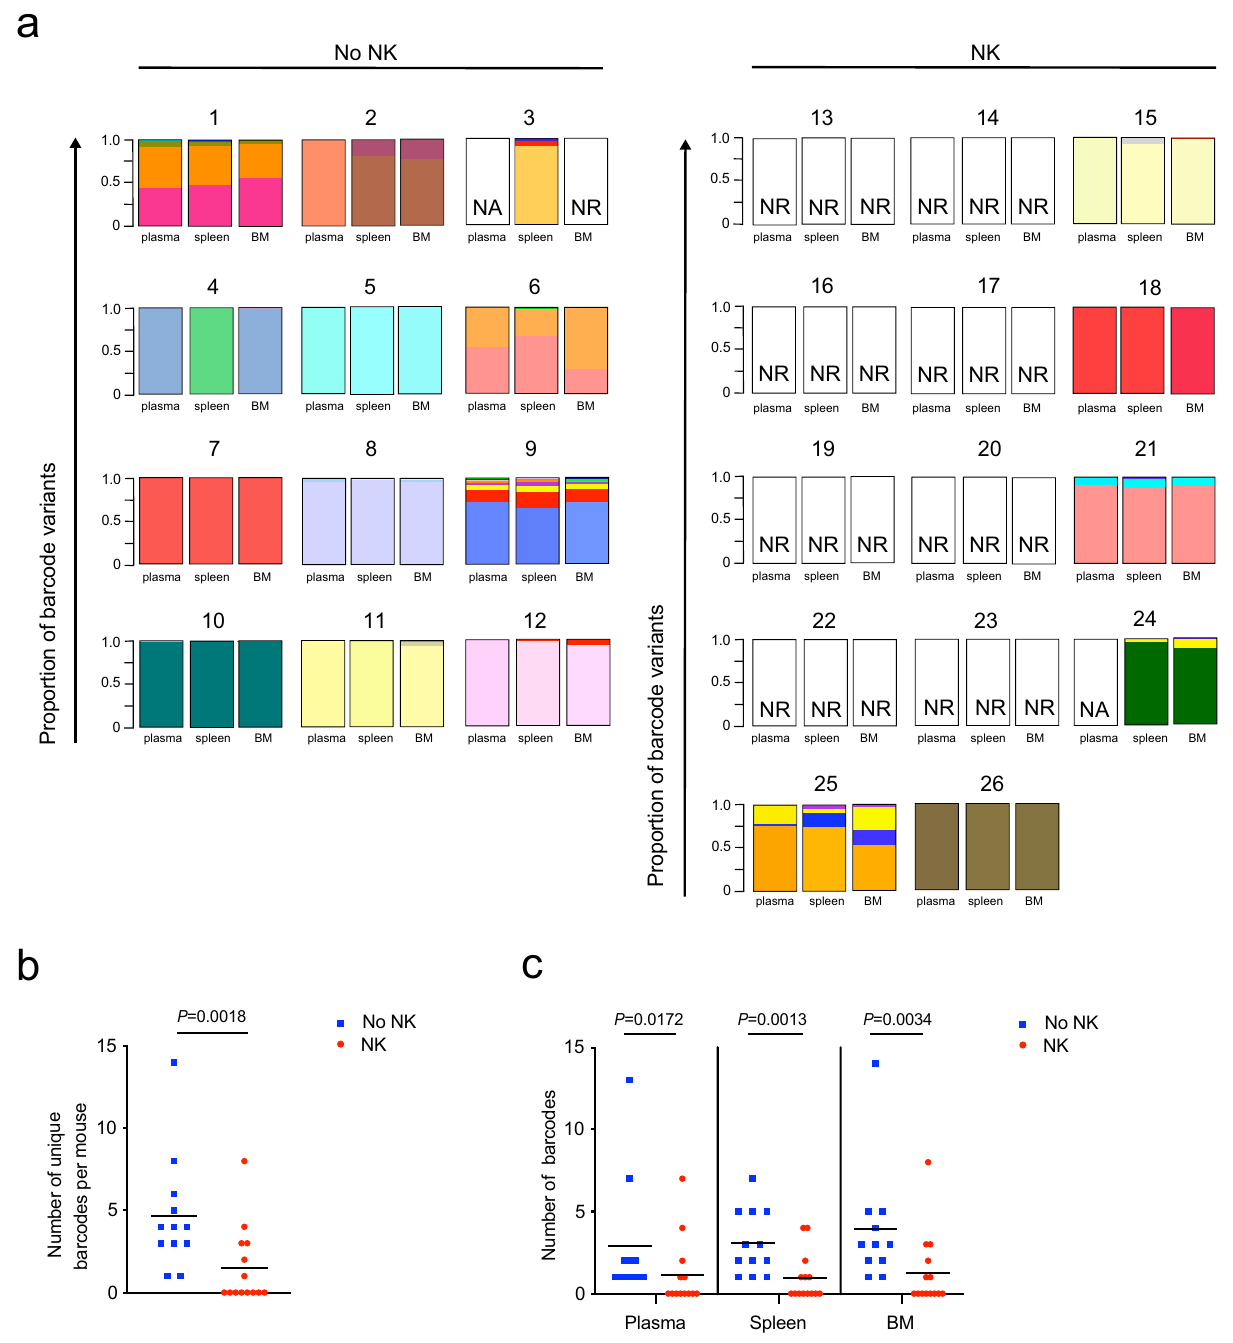
Fig. 4 NK cells decrease barcode diversity in NL-HABC infected mice. a Stacked bar plots display the relative frequencies and distribution of major barcode variants identi fi ed in the plasma, spleen, and bone marrow “ BM ” of mice treated with or without NK cells during ART interruption described in Fig. 2. Individual barcodes are represented by one color. “ NR “ is no rebound, undetectable HIV RNA copies measured by qRT-PCR. “ NA ” is no amplicon detected of the barcode region by nested PCR. b Number of unique barcodes quanti fi ed by deep sequencing of viral RNA from pooled organs per mouse in the No NK (blue) and NK (red) groups. n = 12 biologically independent animals in the No NK group, n = 14 biologically independent animals in NK group. c Number of unique barcodes from the plasma ( n = 11 biologically independent animals in no NK group, 13 biologically independent animals in NK group), spleen, and BM ( n = 12 biologically independent animals in no NK group, n = 14 biologically independent animals in NK group) of each mouse. Horizontal bars represent the means. P values were calculated using the two-tailed Mann-Whitney test. Source data are provided as a Source Data fi animals (mice #2_3 and #2_4 in Supplementary Table 1). In but not #2_8, induced virus in Supplementary Table 1). These addition, we were able to induce replication-competent virus results suggest that although NK cells can ef fi ciently eliminate from the splenocytes of seven out of eight (88%) mice that reactivated cells and their viral clones as they rebound, they were received NK cells even though they lacked rebound plasma not effective at kicking and killing latently infected cells out of viremia (mice #2_5, #2_6, #2_9, #3_10, #3_11, #3_13, and #3_14, latency.